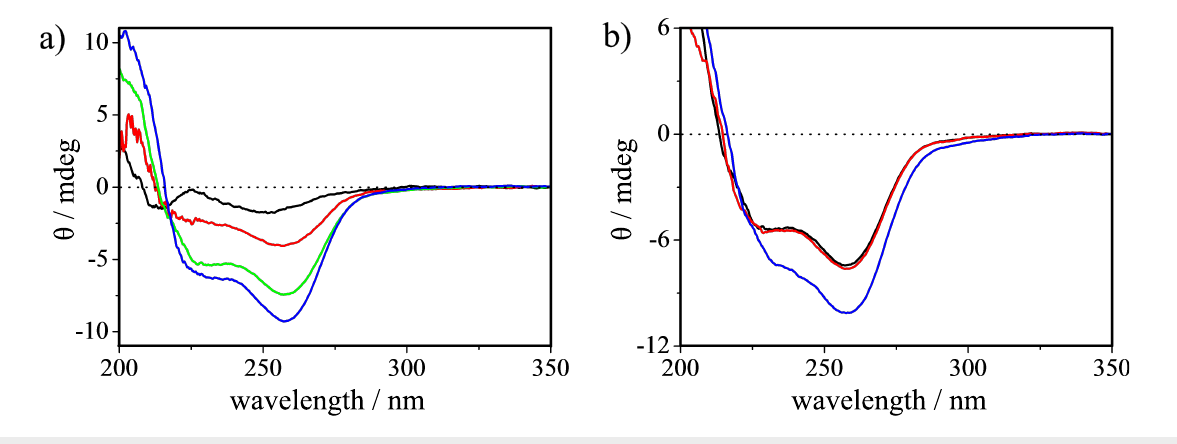
Figure 2: Circular dichroism spectra of 3 (67 μ g/mL) (a) in water at pH 1.9 (black), 4.0 (red), 7.5 (green) and 10 (blue) and (b) in water at pH 7.5 (black), in 10% ethanol (red) and in 50% ethanol (blue).